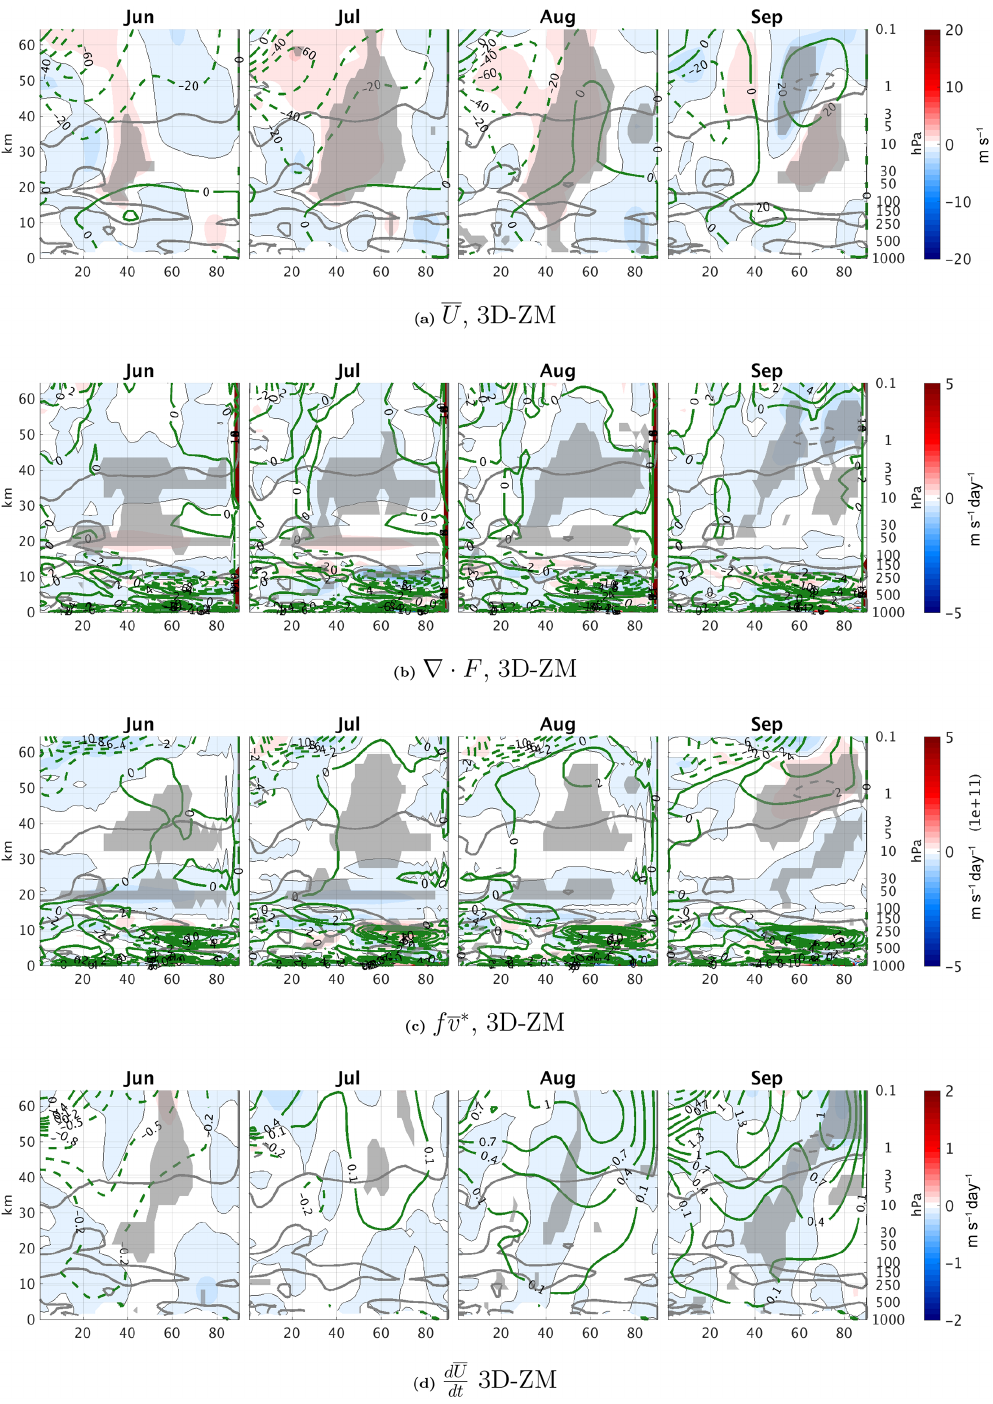
Figure A3. Monthly climatology differences between 3-D and ZM ozone runs during summer, June–September of the zonal mean zonal wind (a) , zonal mean zonal wind tendency from EP flux convergence (b) , the time tendency from the Coriolis term (c) , and the total time tendency (d) . Statistically significant areas are shown by gray